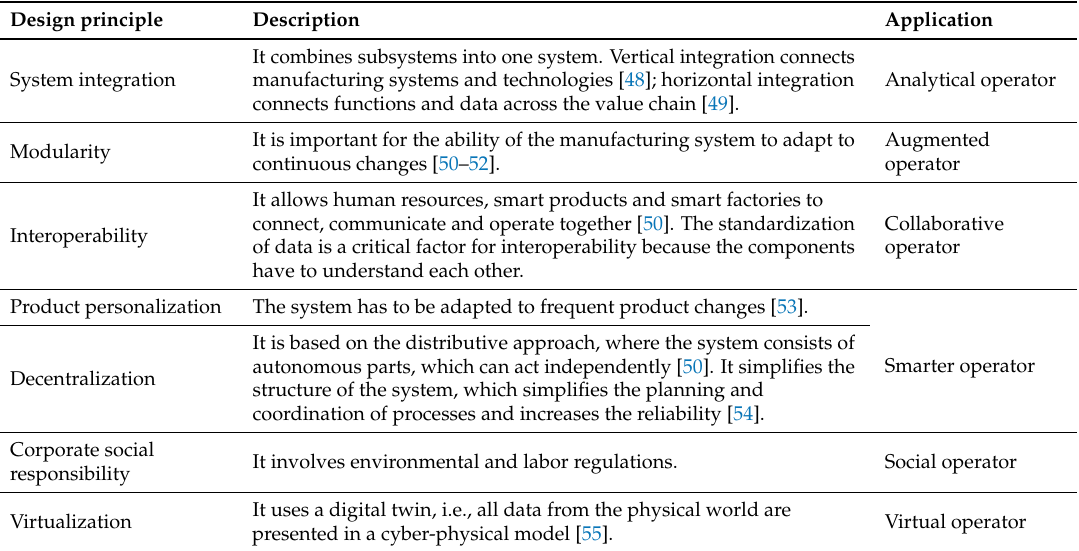
Table 2. Design principles of Industry 4.0 applied to Operator 4.0